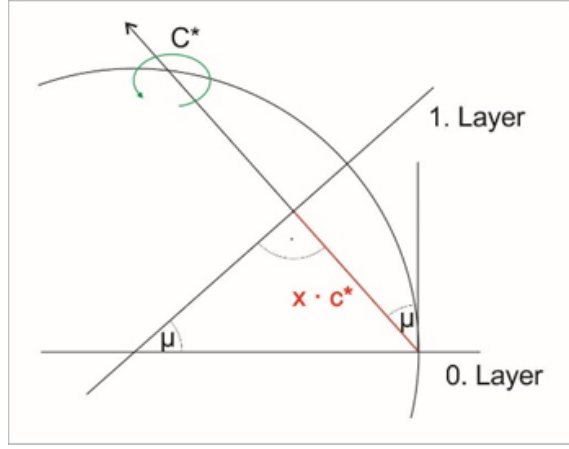
Figure 3: Flat-Cone Geometry in the reciprocal